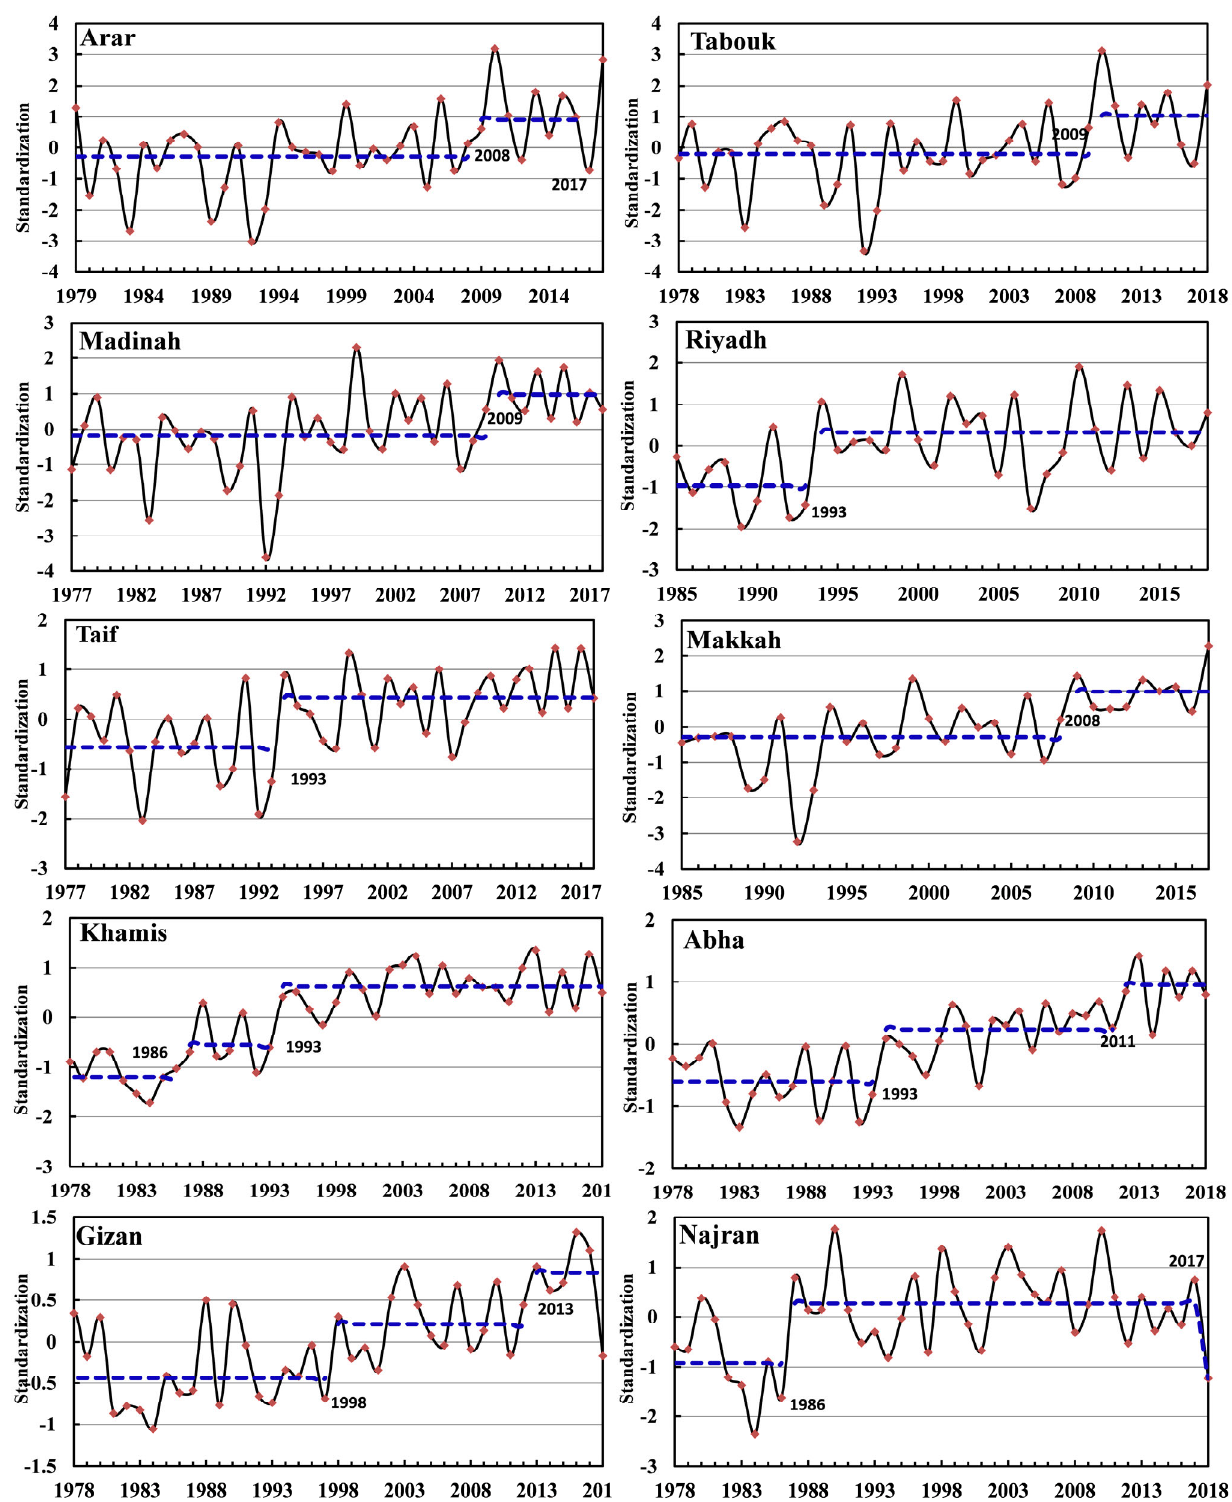
Figure 4. ( a ) The Cumulative Seasonal Means time series and the averaged Cumulative Seasonal Means in Turaif, Guriat, Arar, Aljouf, Rafha, Tabouk, Qaisumah, Hail, Gassim, Wejh, Ahsa and Riyadh. ‐‐‐‐‐‐‐‐‐ The means of CSM and the CSM time series. The stations are arranged from